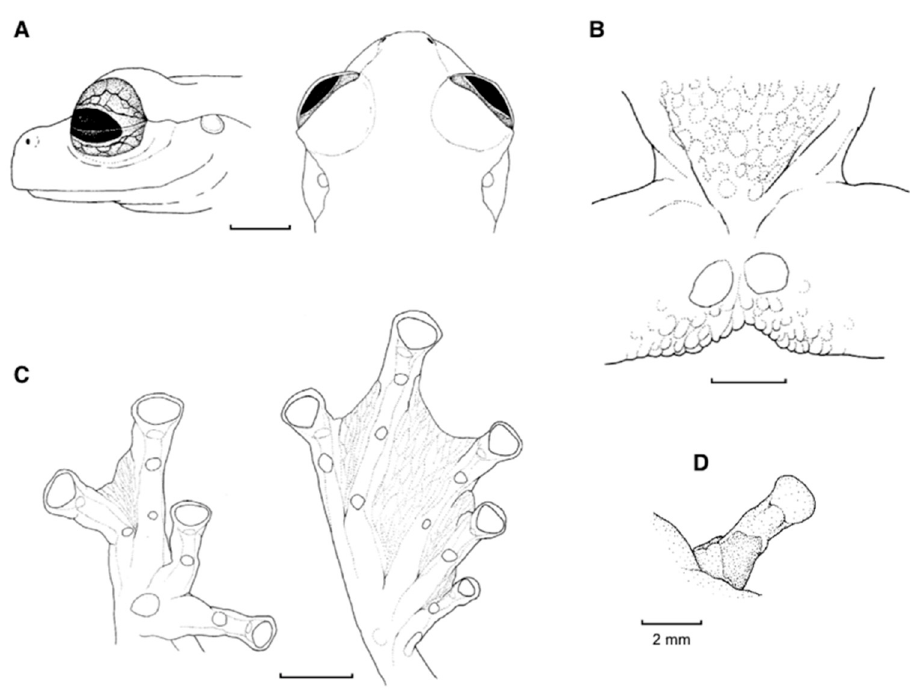
Figure 90. Espadarana callistomma . ( A ) Head in lateral and dorsal views, paratype, adult male, QCAZ 28803. ( B ) Ventral surfaces of thighs showing enlarged subcloacal tubercles, holotype, adult male, QCAZ 25832. ( C ) Hand and foot in ventral view, paratype, adult male, QCAZ 28803. ( D ) Nuptial pad and thumb in dorsal view, holotype, adult male, QCAZ 25832. Modified from Guayasamin and Trueb [9].